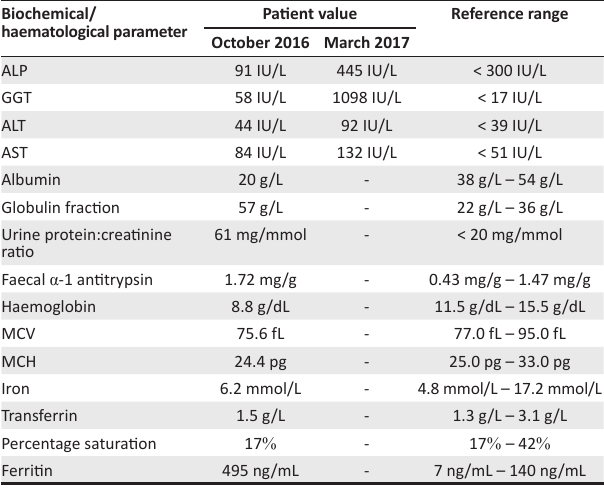
TABLE 2: Histology results. TABLE 1: Laboratory results.